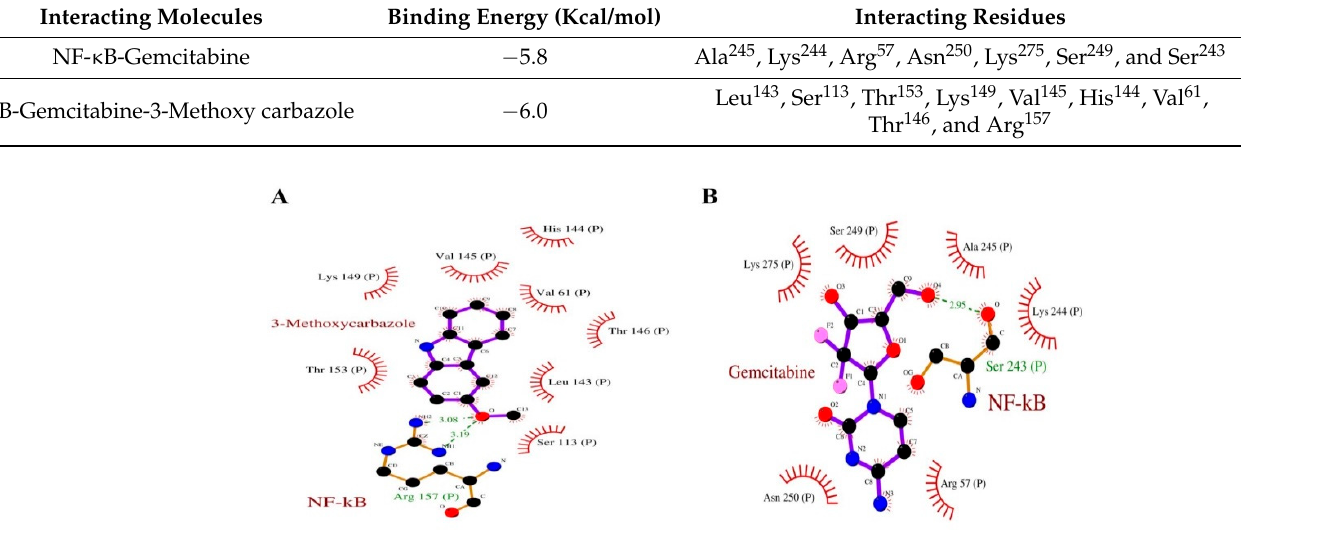
Figure 2. Ligplots showing the molecular interaction of the NF- κ B precursor p105 with ( A ) 3-Methoxy carbazole and ( B ) Gemcitabine.